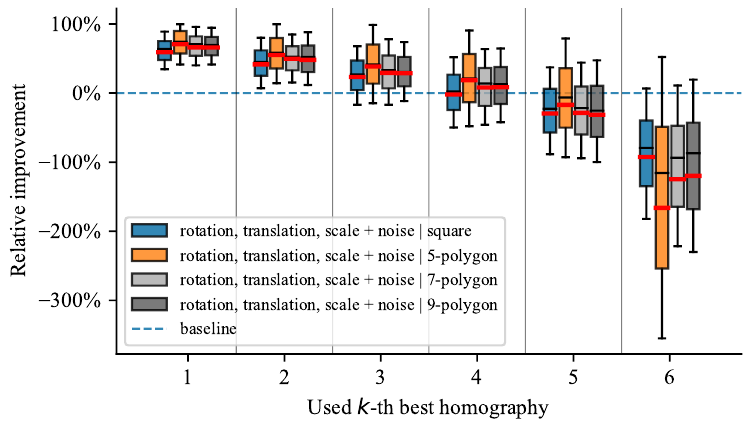
Figure 8. Results for different marker shapes.